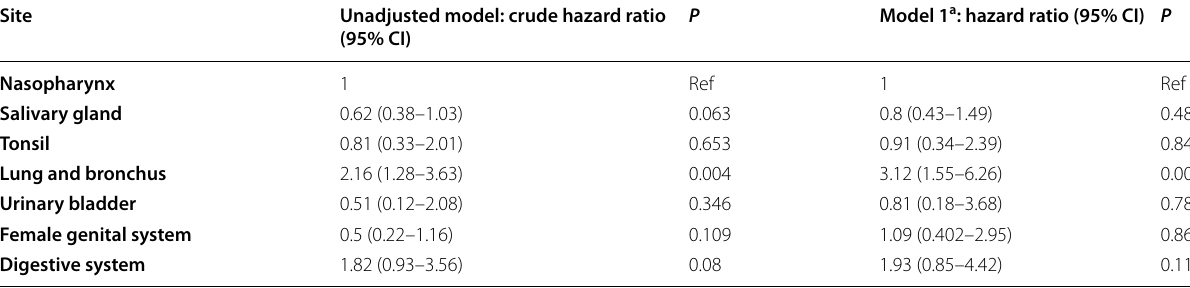
Table 4 Survival analysis for patients presenting with localized disease